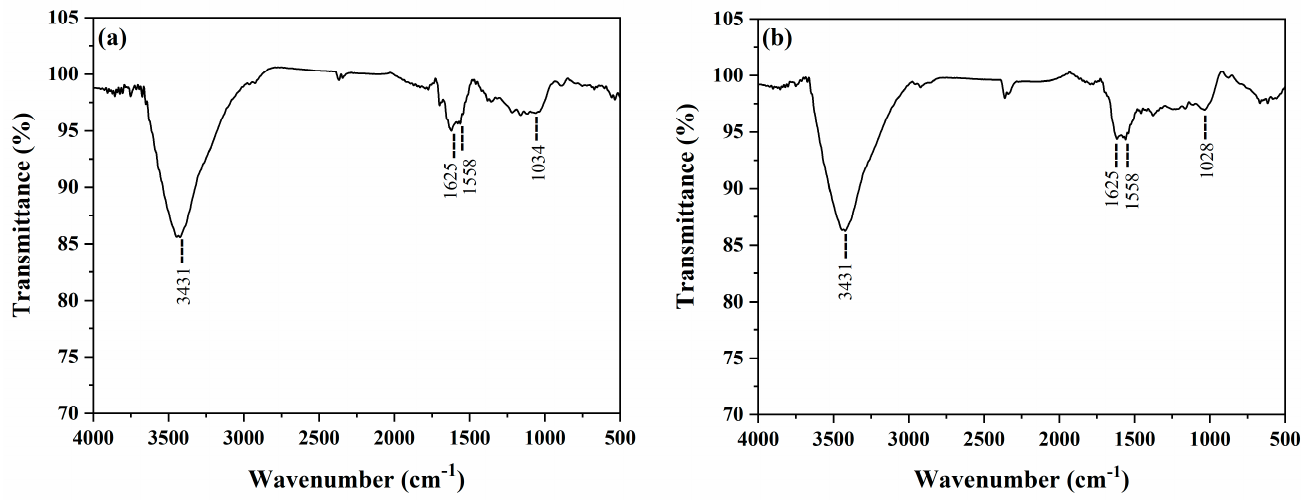
Figure 2. FTIR vibrational spectra of ( a ) MAC1105 and ( b ) MAC111.